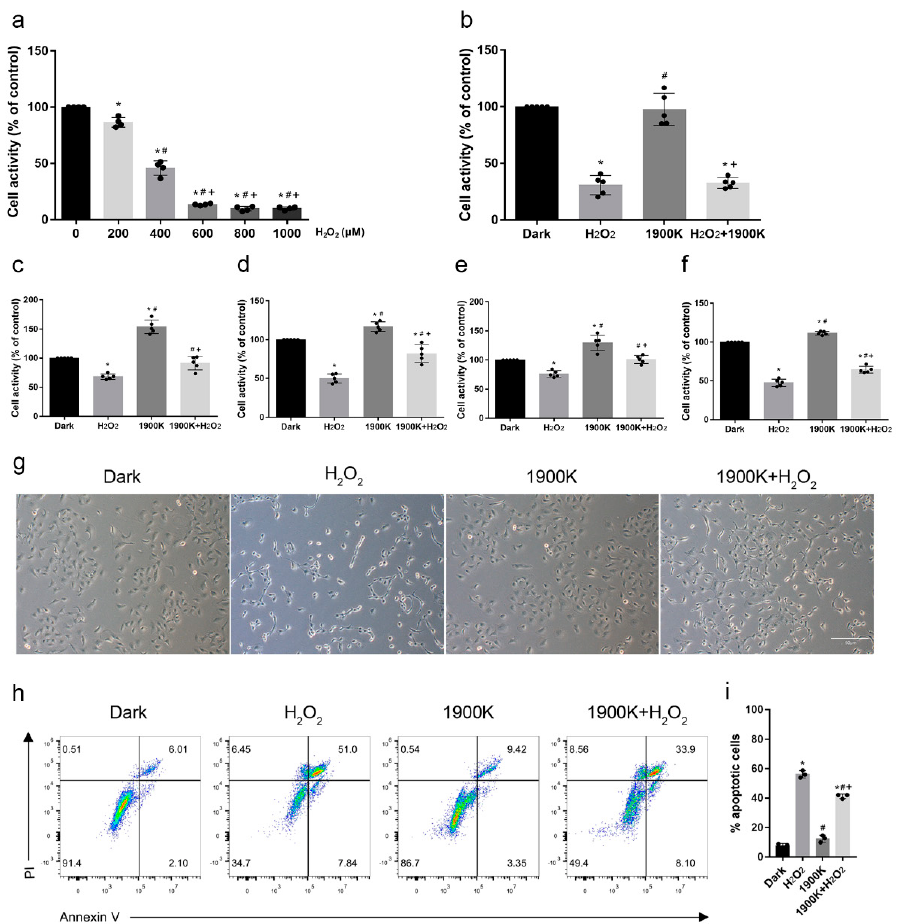
Figure 2. Pretreatment with the 1900 K LEDs at 10 W/m 2 reduced the death of ARPE-19 cells. ( a ) Hydrogen peroxide (H 2 O 2 ) concentration selection; n = 4. * Significantly different from 0 µ M (one-way ANOVA: 200 µ M, p = 0.0003; 400, 600, 800, and 1000 µ M, p < 0.0001); # significantly different from 200 µ M (one-way ANOVA, p < 0.0001); + significantly different from 400 µ M (one-way ANOVA, p < 0.0001). ( b ) Cell activity of ARPE-19 cells in the light post-treatment paradigm; n = 5. * Significantly different from dark group (one-way ANOVA: H 2 O 2 and H 2 O 2 + 1900 K, p < 0.0001); # significantly different from H 2 O 2 group (one-way ANOVA, p < 0.0001); + significantly different from 1900 K group (one-way ANOVA, p < 0.0001). Cell activity of ARPE-19 cells after removing H 2 O 2 at 0 h ( c ), 3 h ( d ), 9 h ( e ), and 24 h ( f ) in the pre-light treatment; n = 5. * Significantly different from dark group (one-way ANOVA: 0 h, H 2 O 2 , p = 0.0001 and 1900 K, p < 0.0001; 3 h, H 2 O 2 , p < 0.0001, 1900 K, p = 0.0079, and 1900 K + H 2 O 2 , p = 0.005; 9 h, H 2 O 2 , p = 0.0012 and 1900 K, p = 0.0001; 24 h, H 2 O 2 and 1900 K + H 2 O 2 , p < 0.0001 and 1900 K, p = 0.0003); # significantly different from H 2 O 2 (one-way ANOVA: 0 h, 1900 K, p < 0.0001 and 1900 K + H 2 O 2 , p = 0.0032; 3 h, 1900 K and 1900 K + H 2 O 2 , p < 0.0001; 9h, 1900 K, p < 0.0001 and 1900 K + H 2 O 2 , p = 0.0009; 24 h, 1900 K and 1900 K + H 2 O 2 , p < 0.0001); + significantly different from 1900 K (one-way ANOVA: 0 h, 1900 K + H 2 O 2 , p < 0.0001; 3 h, 1900 K + H 2 O 2 , p < 0.0001; 9 h, 1900 K + H 2 O 2 , p = 0.0002; 24 h, 1900 K + H 2 O 2 , p < 0.0001). The morphology of cells ( g ) and cell apoptosis detection ( h ) in the light pretreatment paradigm; concentration of H 2 O 2 = 1000 μ M. ( i ) Quantitative analysis of apoptosis rate; n = 3. * Significantly different from dark group (one-way ANOVA, p < 0.0001); # significantly different from H 2 O 2 group (one-way ANOVA, p < 0.0001); + significantly different from 1900 K group (one-way ANOVA, p < 0.0001). The data are presented as the mean ± SD. Bars in the bright field, 50 μ m.